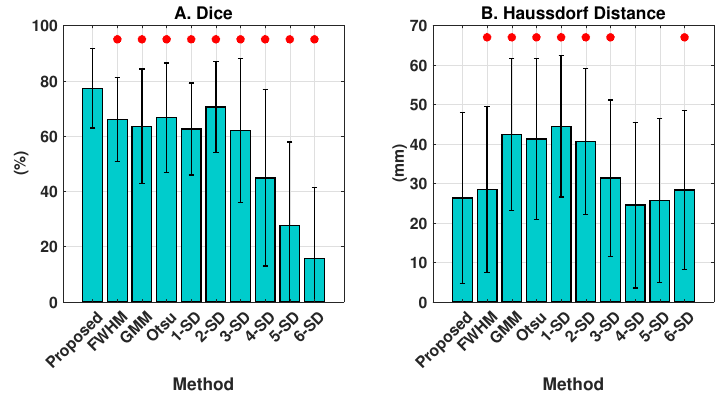
Figure 4. Segmentation performance. FWHM: Full-width at half-maximum; GMM: Gaussian mixture model; n-SD: n-standard deviation thresholding from remote myocardium. Red dots indicate p < 0.05 with Mann–Whitney